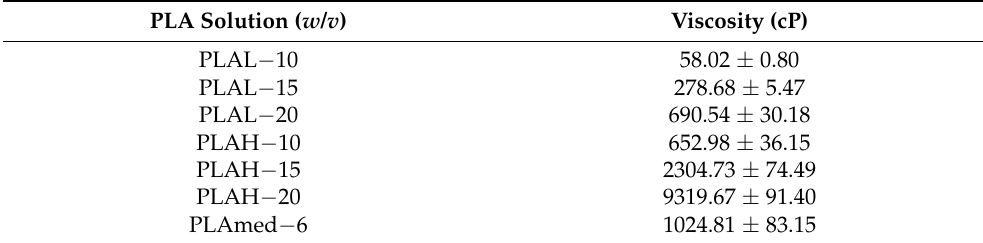
Table 4. PLA solution viscosity for